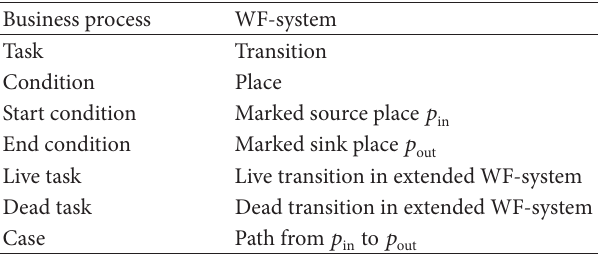
Table 1: Description of a business procedure in a